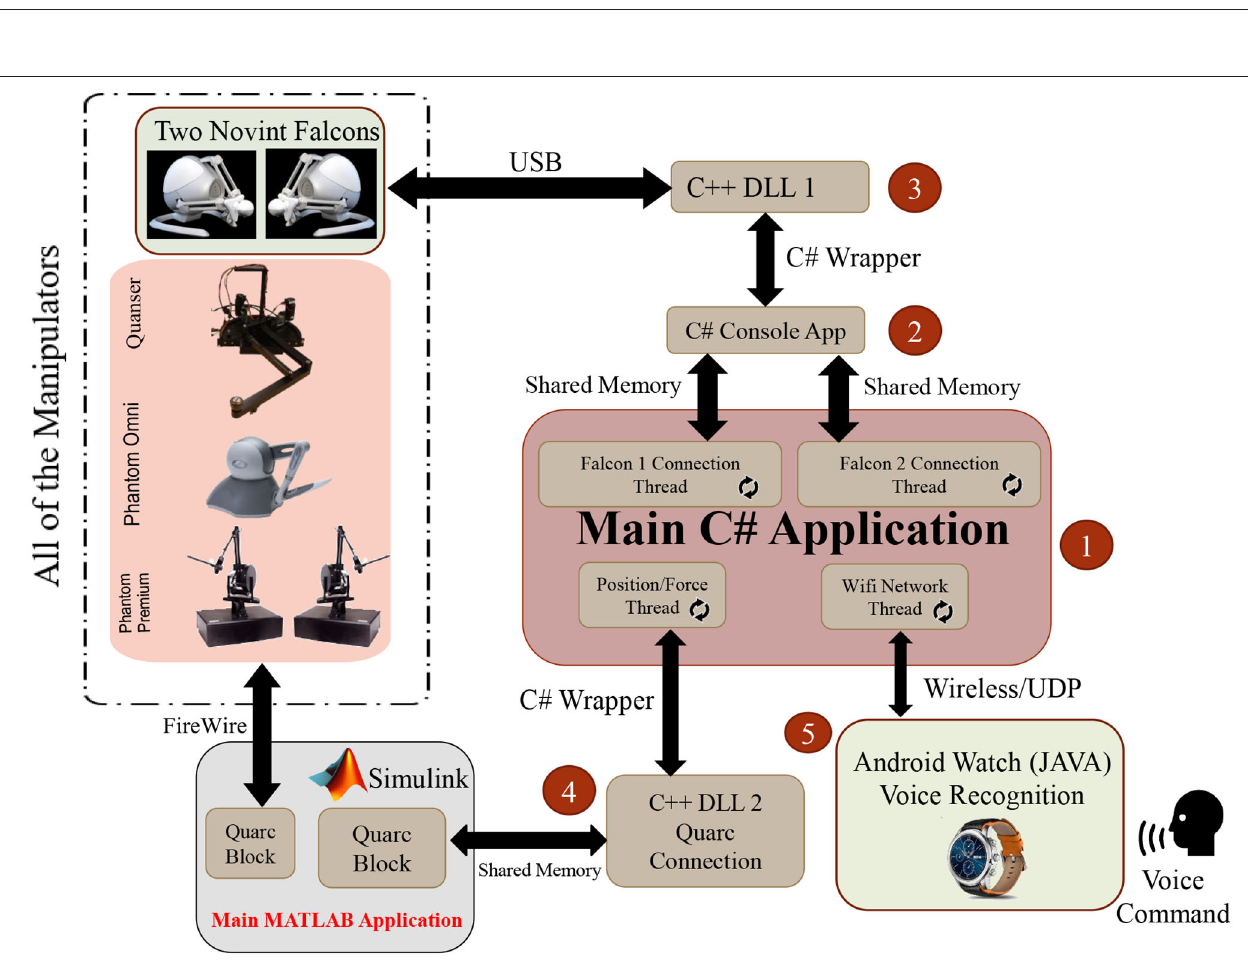
Frontiers in Robotics and AI |